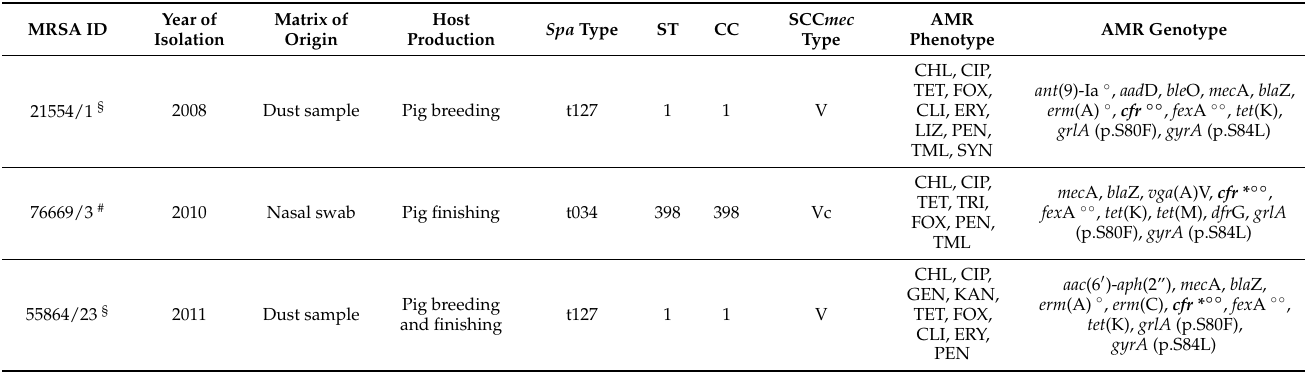
Table 1. Genomic and phenotypic characteristics of the three cfr -positive LA-MRSA isolates analysed by WGS (Illumina short